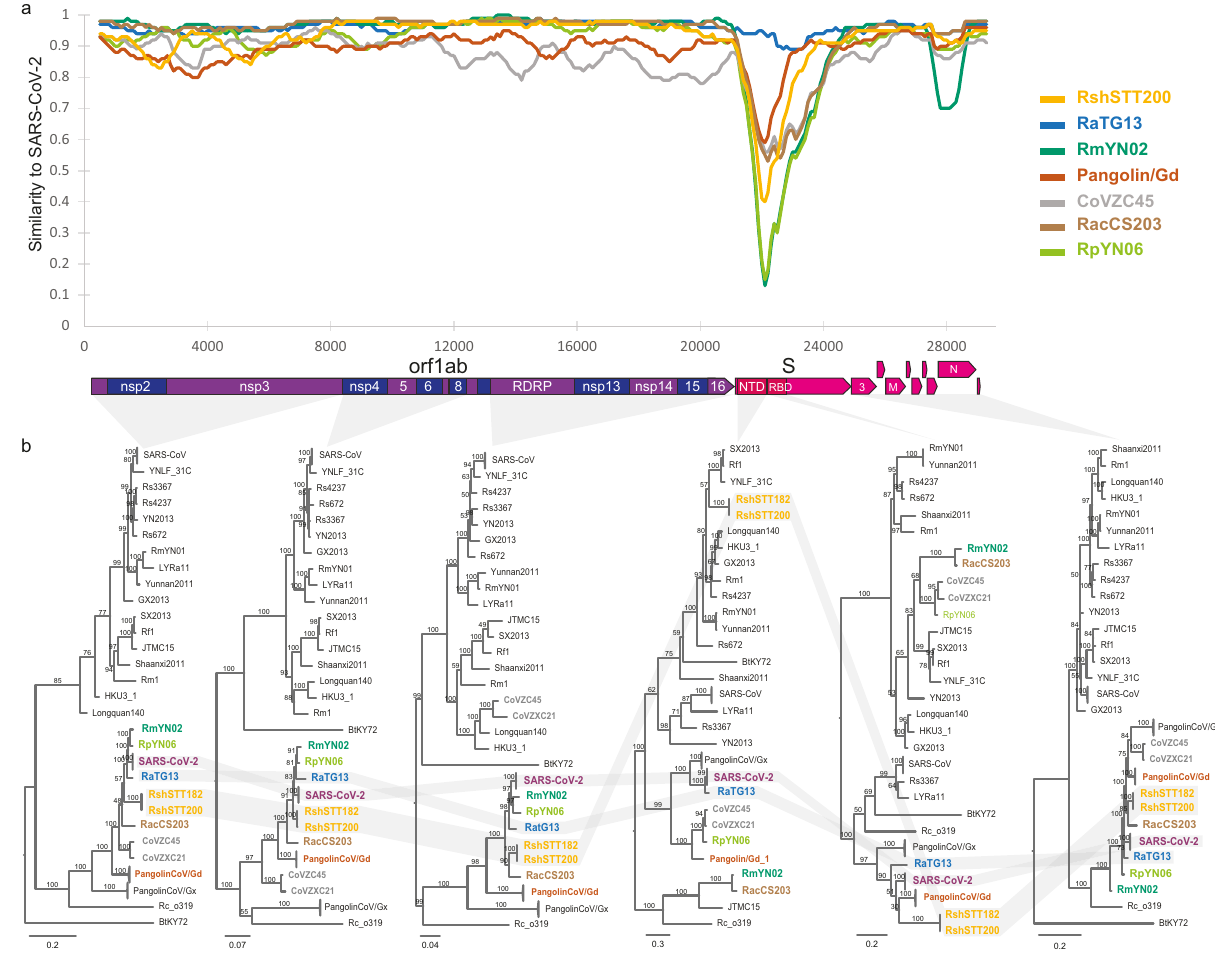
Fig. 2 Recombination analysis. a Sliding window analysis of changing patterns of sequence similarity between SARS-CoV-2 and related coronaviruses from China and Cambodia. CoVZXC21 and CoVZC45 were merged for this analysis. Source data are provided as a Source Data fi le. b Phylogenetic tree of different genomic regions. From left to right, region spanning: nsp1-nsp3, nsp4-nsp8, rdrp-nsp16, spike N terminal domain (NTD), spike receptor binding domain (RBD), orf3-N. Branch support obtained from 1000 bootstrap replicates are shown. SARS-CoV and SARS-CoV-2 sequences are collapsed, and trees are midpoint rooted for